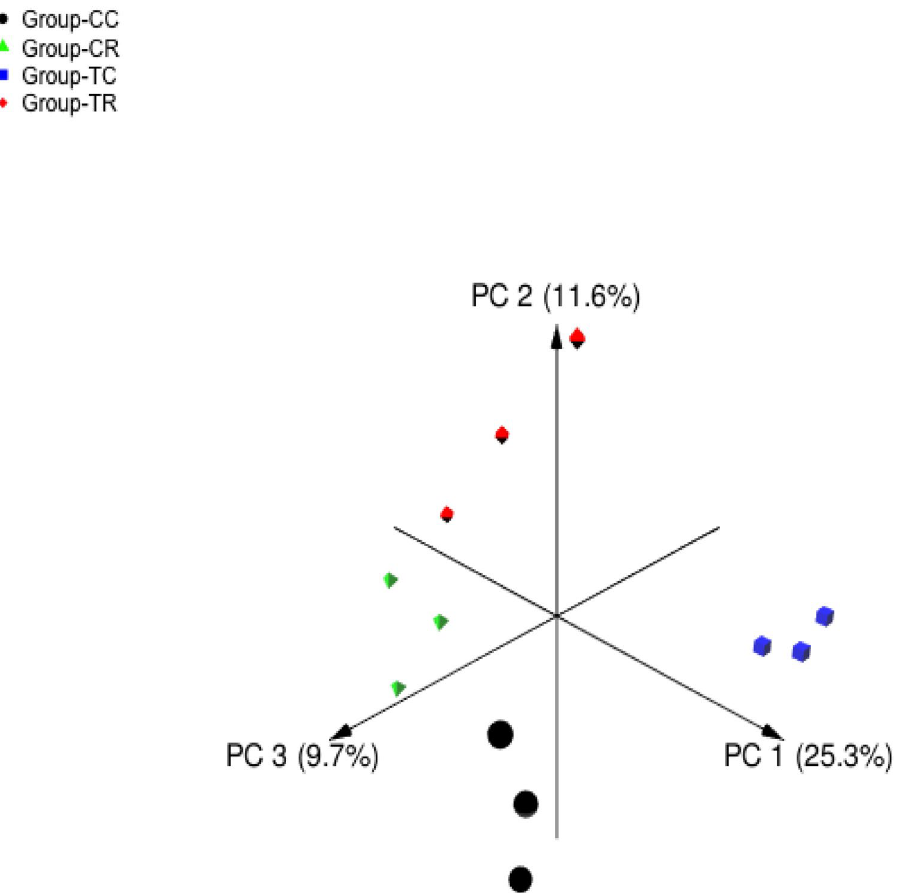
Figure 1. Principal coordinates analysis of bacterial communities in the rumen of supplemented and non- supplemented camels and sheep based on Bray–Curtis dissimilarity. The analysis was conducted between four experimental groups: black circles for non-supplemented camels, green triangles for non-supplemented sheep, blue squares for supplemented camels, and red triangles for supplemented